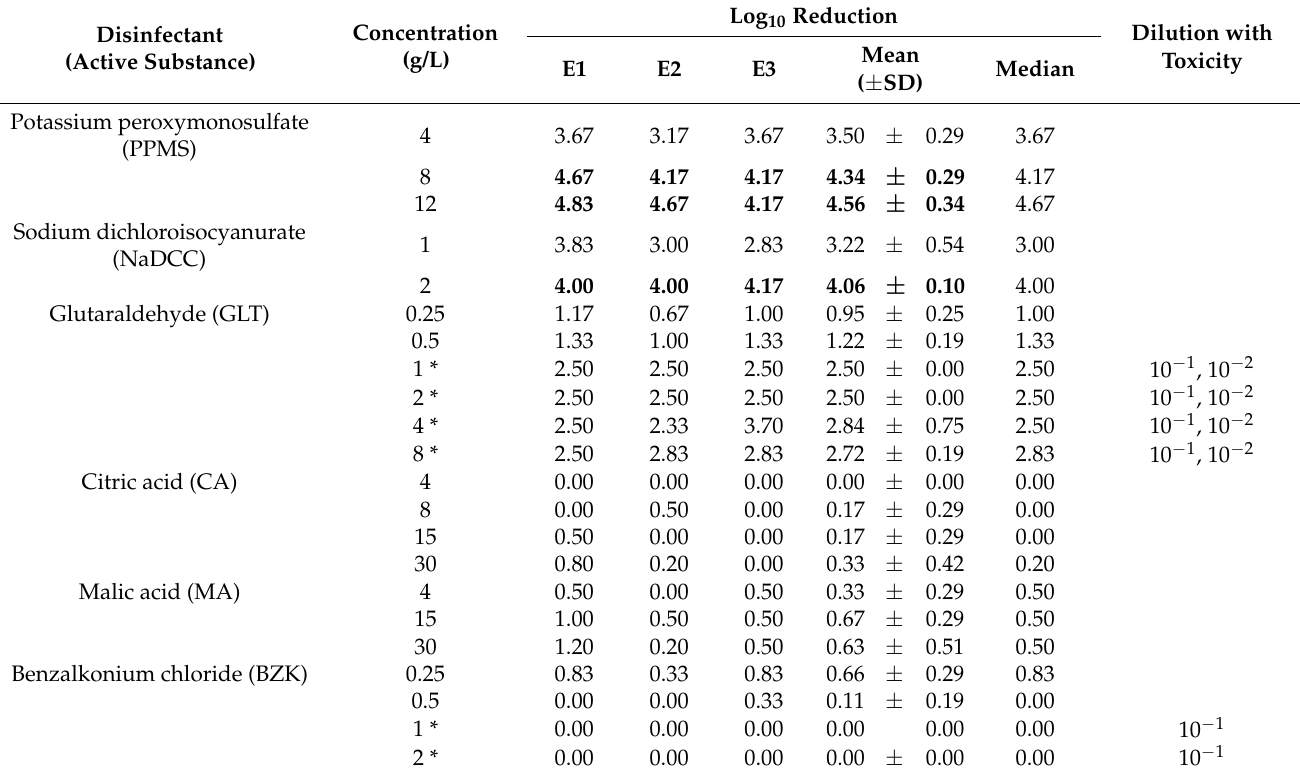
Table 3. Virucidal activity of active substances against bovine enterovirus type